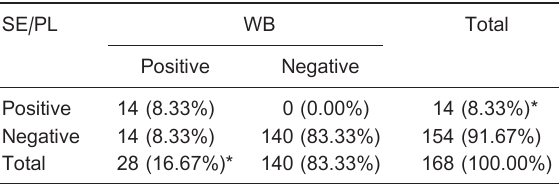
Figure 1. Quantitative comparison of HCMV DNA loads measured with WB, SE and PL. WB: whole blood: SE: serum; PL: plasma. Statistically significant differences ( a P , 0.0001, b P=0.6678, c P , 0.0001, paired t